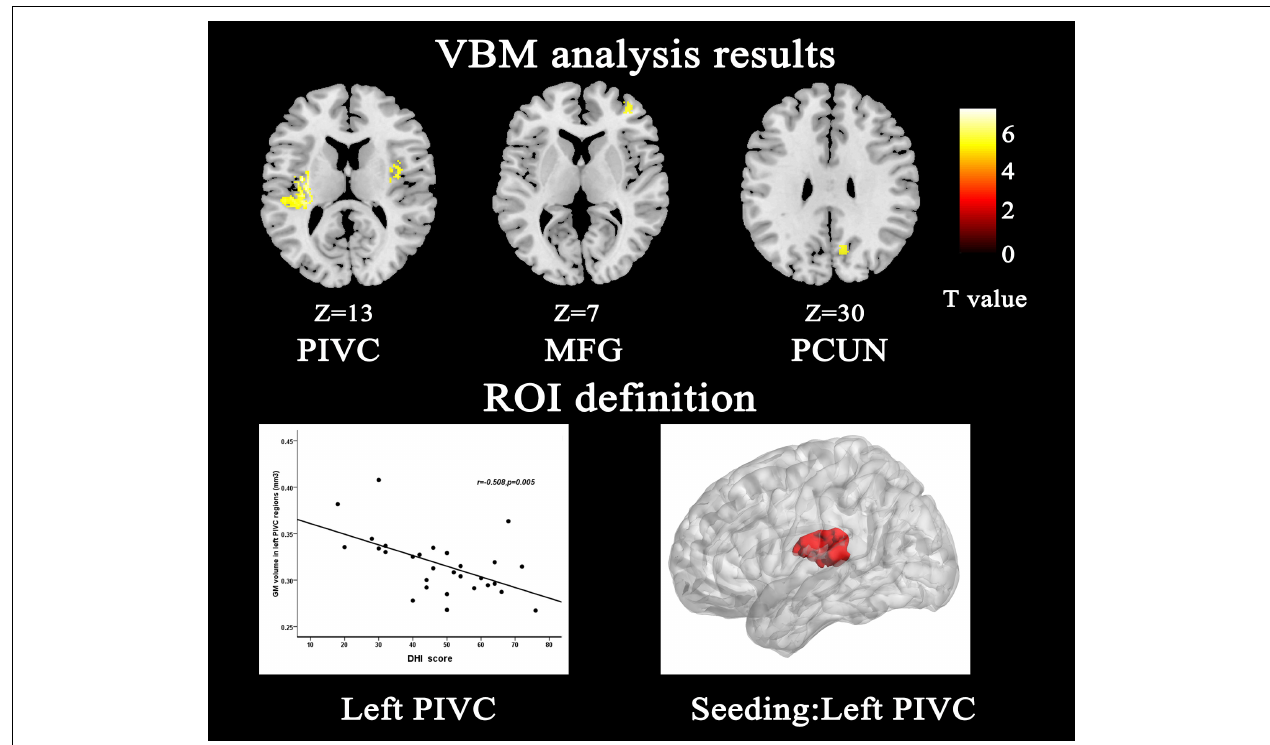
FIGURE 1 | Structural analysis results of patients with vestibular migraine compared with healthy controls ( P < 0.05, FWE corrected, with k > 100 voxels). Gray matter volume of the left parieto-insular vestibular cortex (PIVC) negatively correlated with Dizziness Handicap Inventory score; therefore, we chose the left PIVC as the seeding area for the functional connectivity analysis. The seeding area is indicated by red color. MFG middle frontal gyrus, PCUN Precuneus. TABLE 3 | Brain regions with increased functional connectivity in patients with vestibular migraine compared with healthy controls. Seed ROI Brain region Peak MNI Cluster voxels T − 42 − 42 L posterior insula/parietal regions/ L primary somatosensory cortex/ superior temporal gyrus inferior parietal lobule ROI, region of interest; MNI, Montreal Neurological Institute; L,